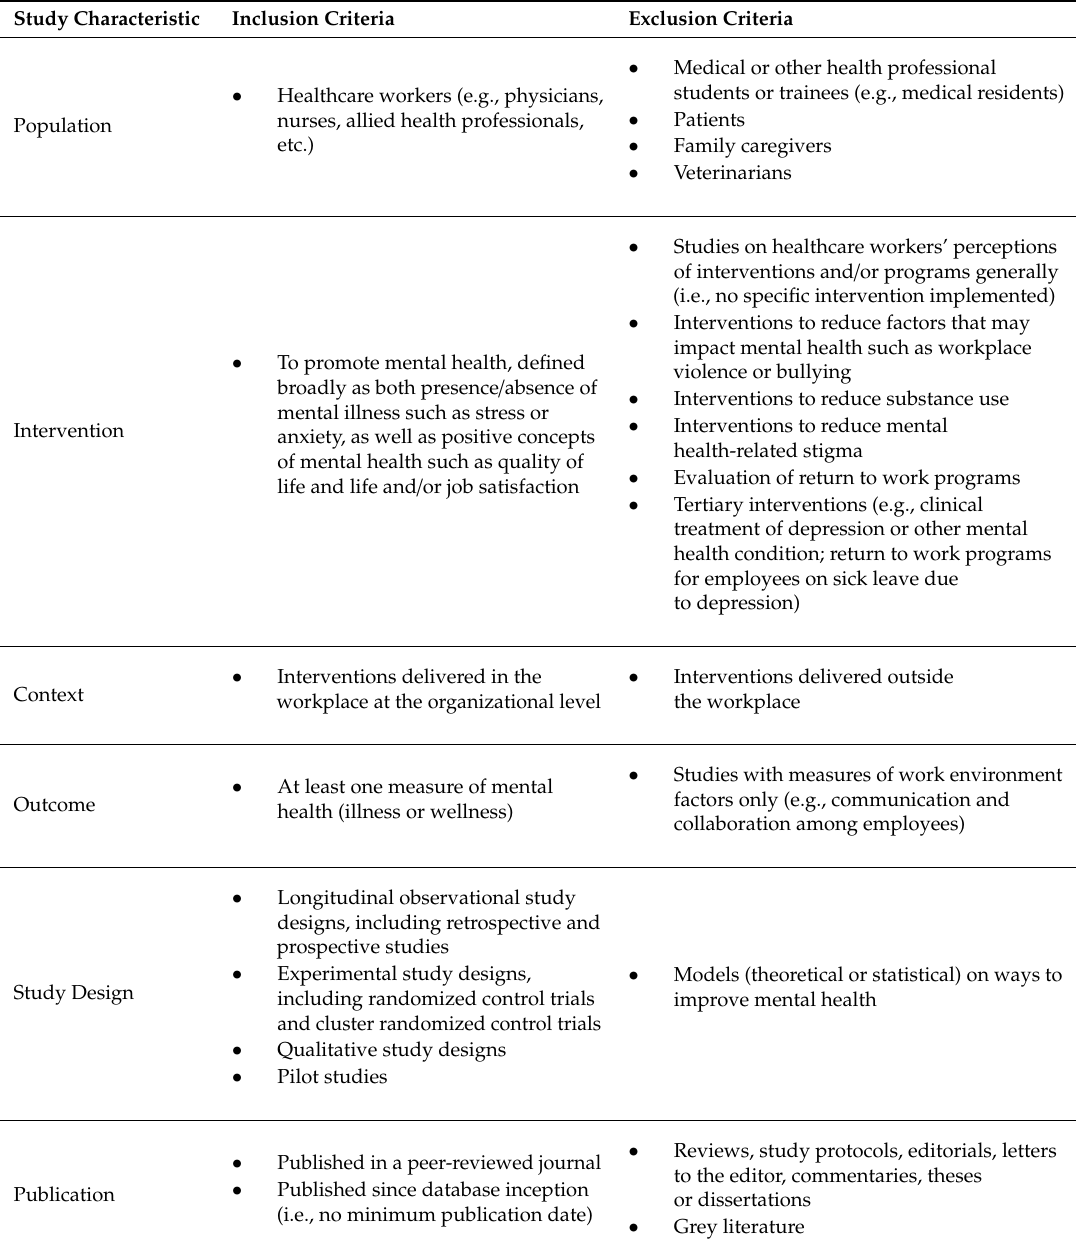
Table 1. Summary of the inclusion and exclusion